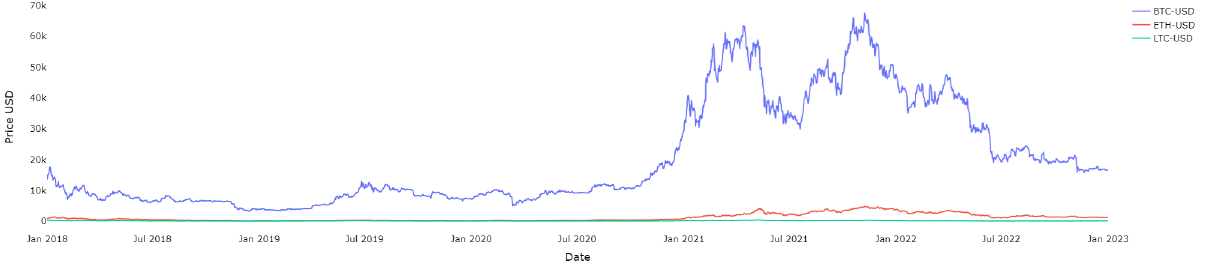
Figure 5. BTC, ETH, and LTC time-series.